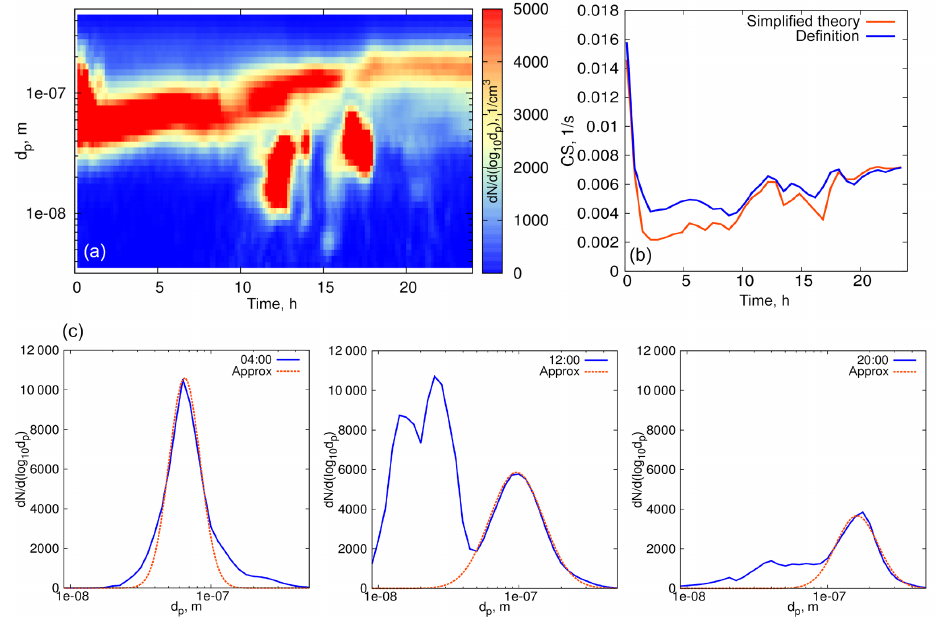
Figure 5. (a) Particle number distribution on 1 June 2008, Hyytiälä. (b) Condensation sink below 500nm, blue: calculated from the definition, orange: calculated using formula (16). (c) Examples of one-mode approximation of the particle number